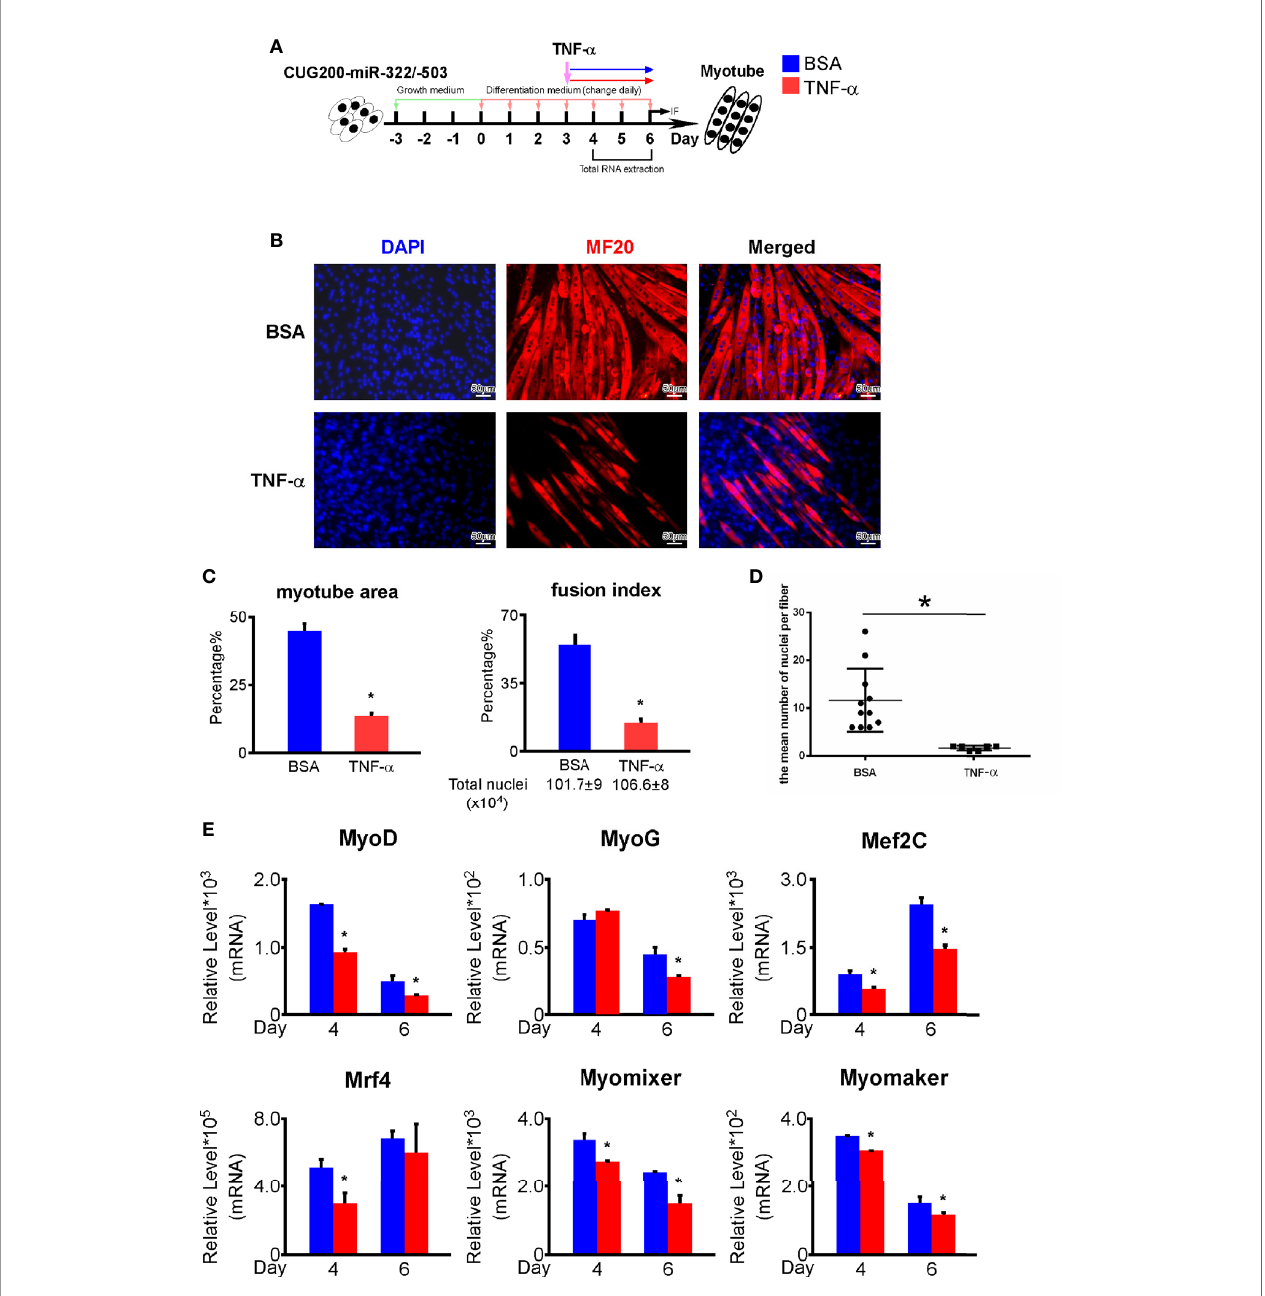
FIGURE 7 | TNF- a treatment repressed the rescue function of miR-322/-503 on DM1 myogenesis. (A) 50 ng/ml TNF- a was added to the miR-322/-503 overexpressing DM1 myoblast differentiation from differentiation day 3 to day 6. 0.1% BSA was used as a control. (B) The TNF- a treatment impaired myotube formation in miR-322/-503 overexpressing DM1 myoblasts. Immuno fl uorescence staining against MF20 was performed on differentiation day 6. (C) The myotube area and fusion index were signi fi cantly decreased with the TNF- a treatment. (D) The mean number of nuclei per fi ber was signi fi cantly decreased with the TNF- a treatment. (E) The expression of muscle regulatory factors (MyoD, MyoG, Mef2C, and Mrf4) and myoblast fusion genes (Myomixer and Myomaker) was signi fi cantly downregulated with the TNF- a treatment. BSA, BSA treatment control; TNF- a , TNF- a treatment; n ≥ 3; *, p <